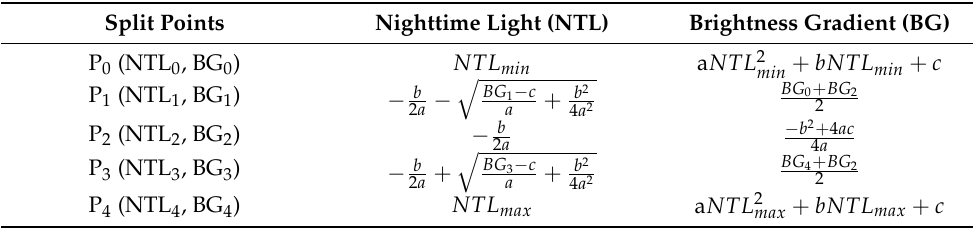
Table 2. Split point calculation of quadratic polynomials.